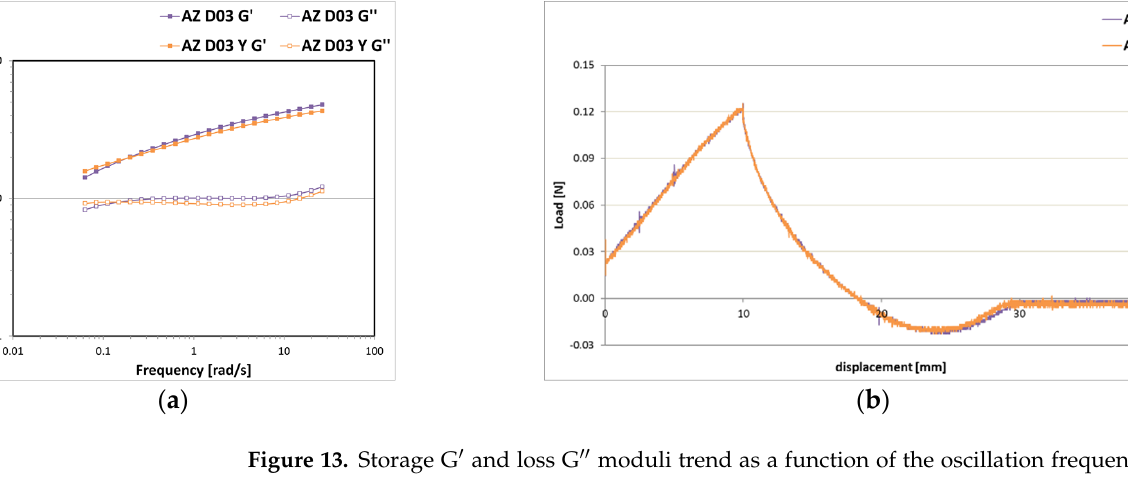
system: after three months at 40 ◦ C in a thermostatic oven, the sample did not show any irreversible